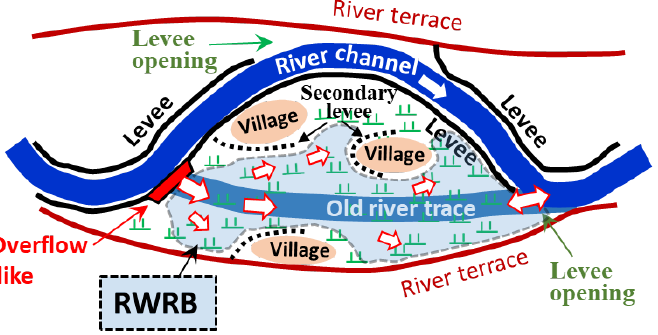
Figure 6. Schematic diagram of